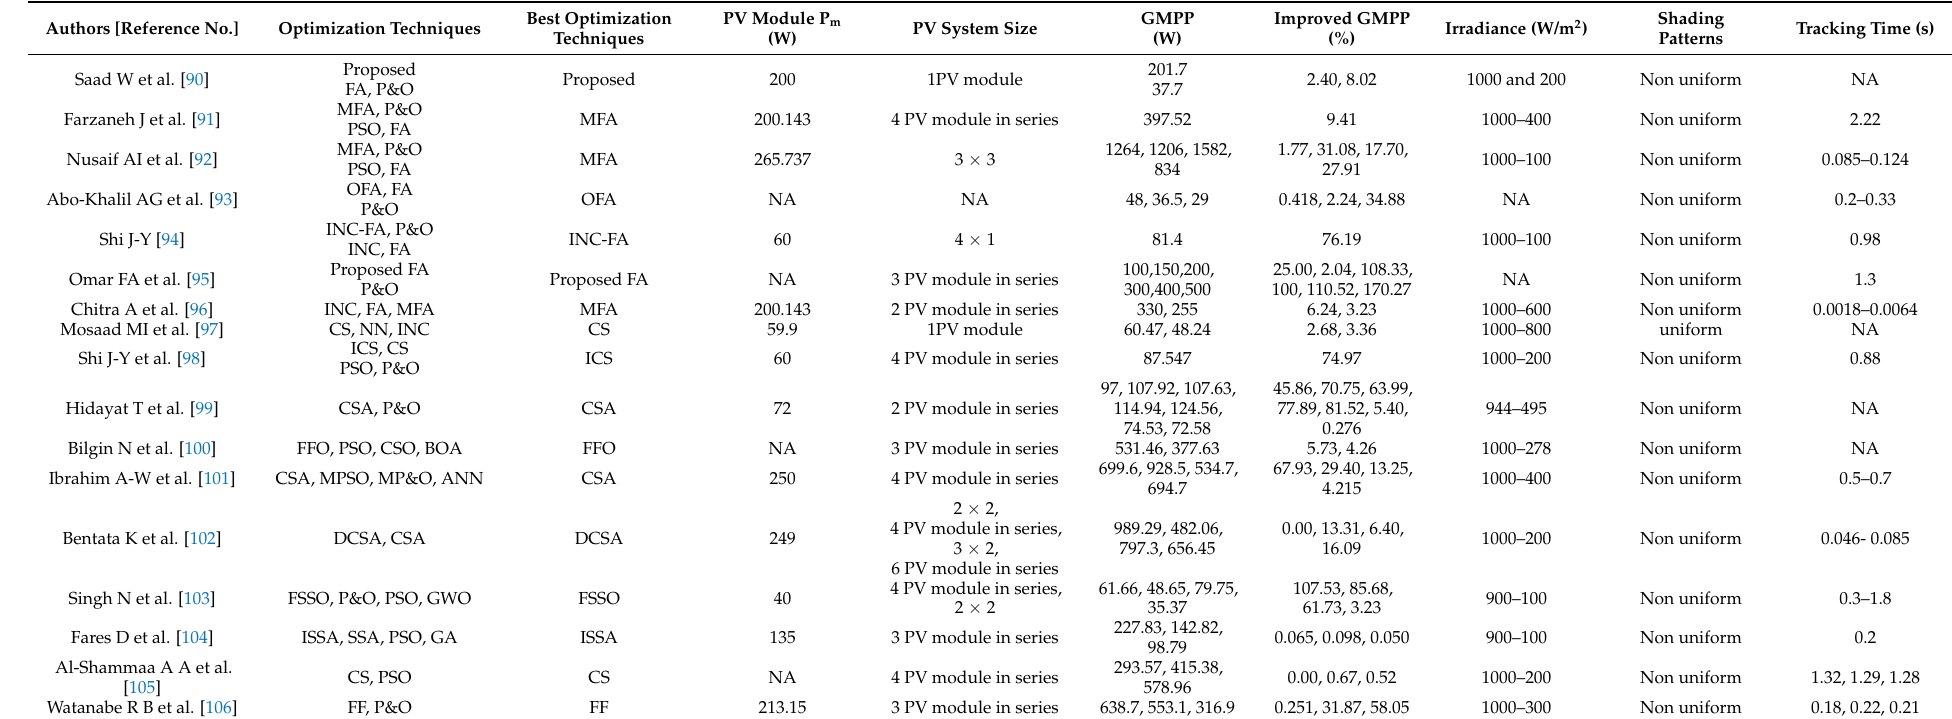
Table 5. Taxonomy on recent reported work on bio-inspired techniques to track